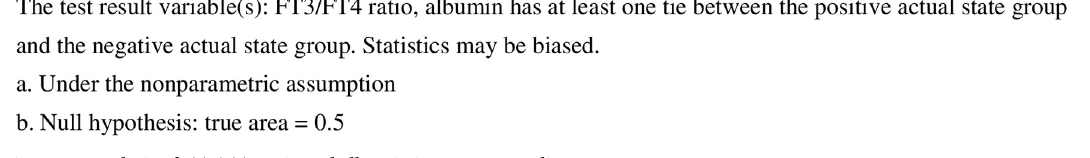
Fig 3. Roc analysis of FT3/FT4 ratio and albumin in 5 year mortality.